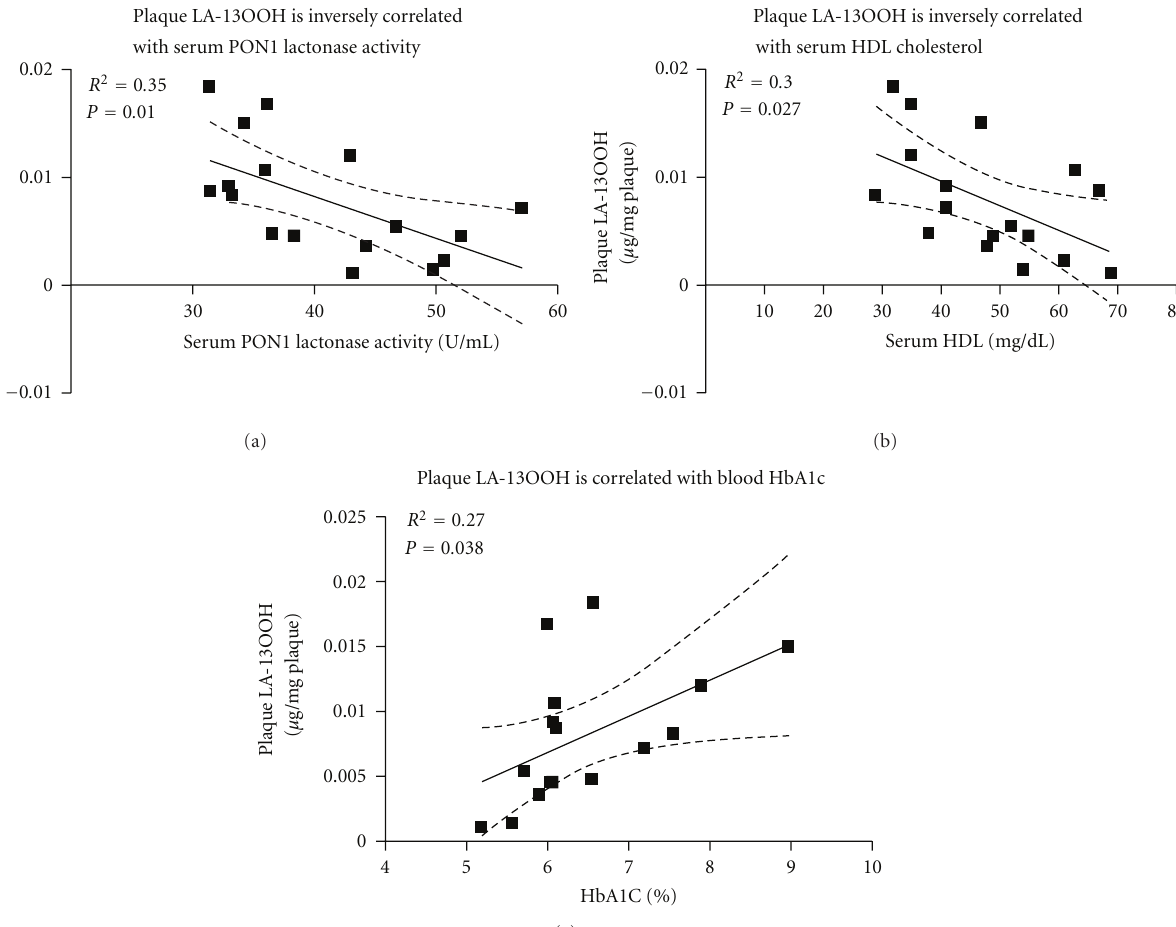
Figure 2: Human plaque linoleic acid hydroperoxide (LA-13OOH) level versus serum HDL, serum PON1 activity and blood hemoglobin (Hb) A1c. Human plaque LA-13OOH is inversely correlated with (a): serum PON1 lactonase activity and (b): serum HDL, but (c): positively correlated with blood